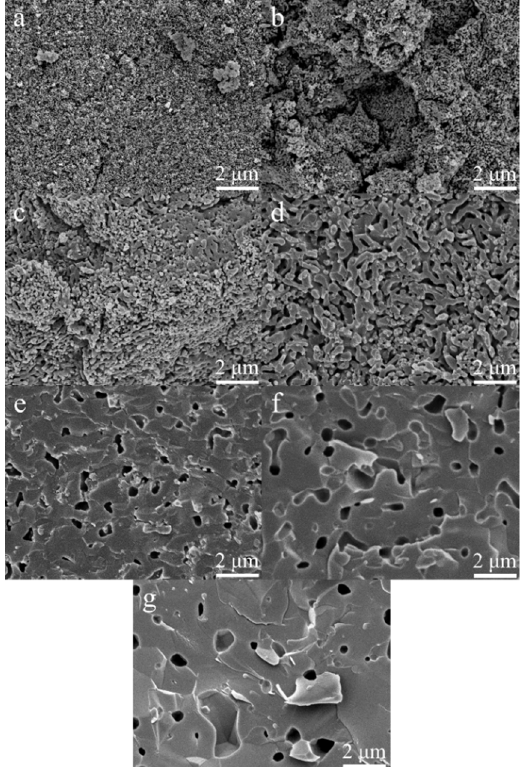
Figure 8. Cross sections of sintered MnHA pellets at 700 °C ( a ); 800 °C ( b ); 900 °C ( c ); 1000 °C ( d ); 1100 °C ( e ); 1200 °C ( f ); and 1300 °C ( g ). Micrographs ( a – g ) were taken at 10,000× magnification.